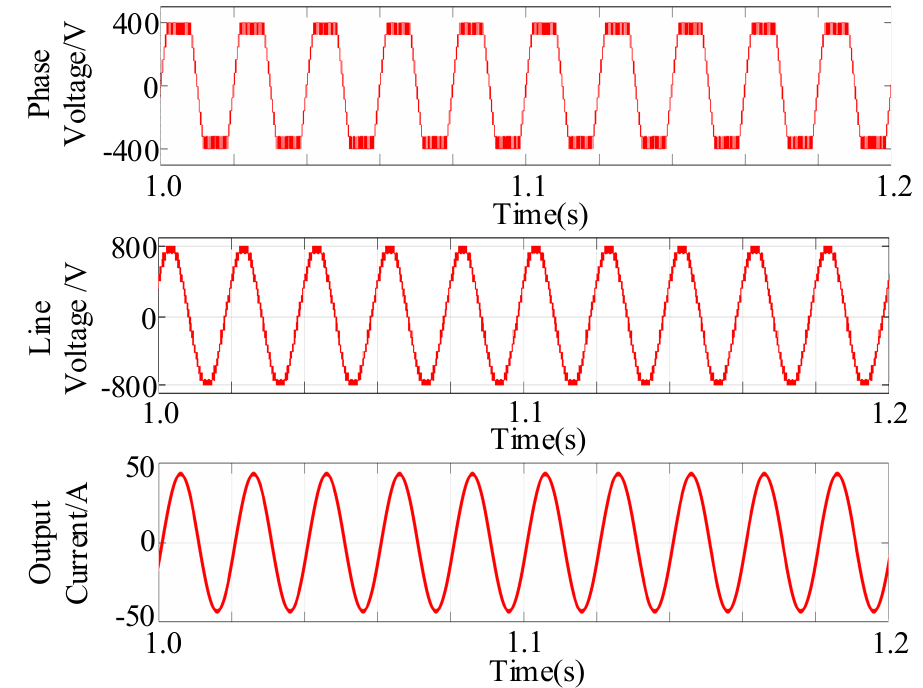
Figure 9. Simulated waveforms (normal operation).